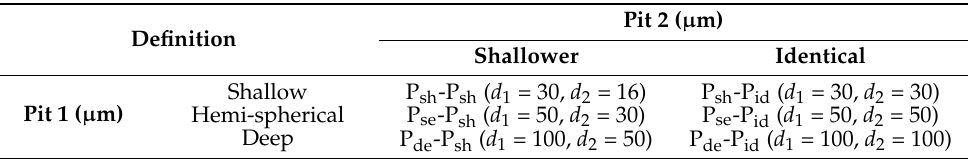
Table 1. The definitions and settings for the configurations of Pit 1 and Pit